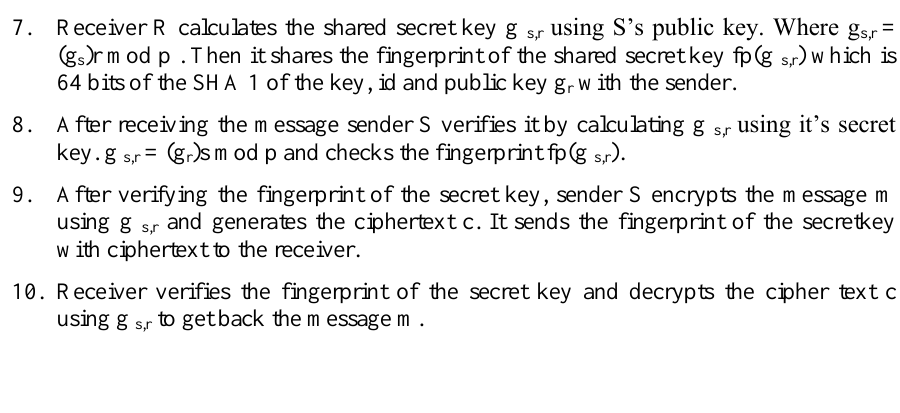
Figure 3. Sequence Diagram of MTProto 2.0 for secure